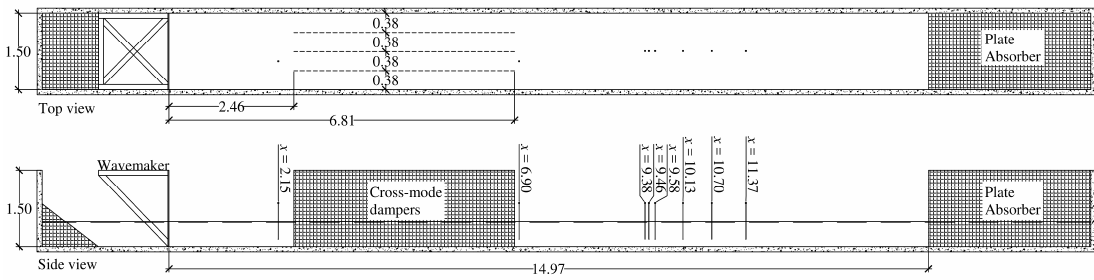
Figure 4. Experimental setup of the wave flume. Measures in meters.